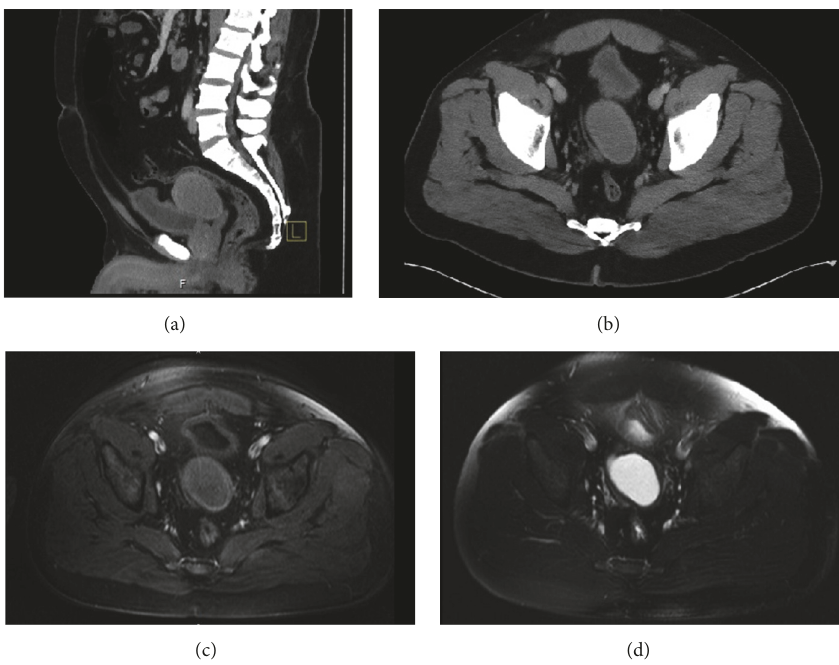
Figure1:Computedtomographyscanwithcontrast[(a)sagittaland(b)axial]displayingacomplexmidlinecysticpelvicmasswiththickwalls found between the bladder and the rectum. Sagittal MRI of the pelvic mass with (c) T1-weighted imaging and (d) intensity on T2-weighted imaging.